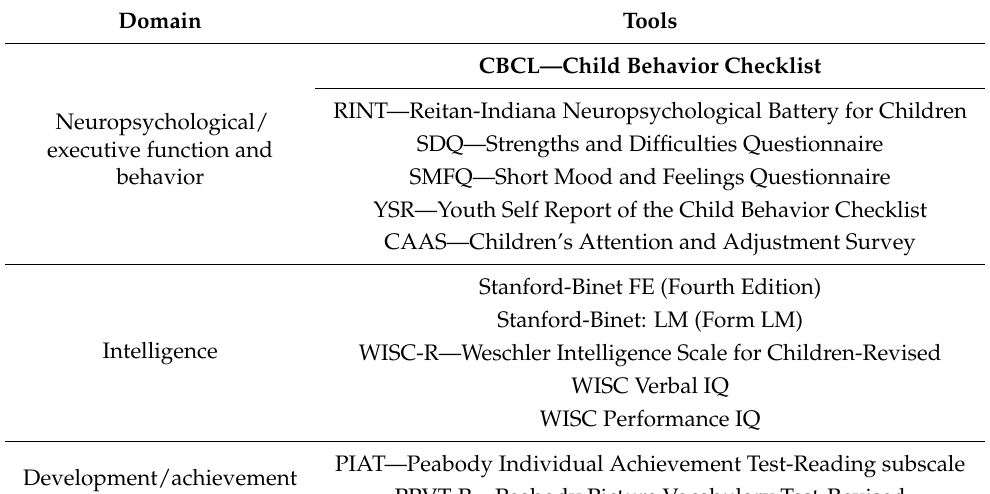
Table 1. Child development assessment tools utilized in included studies, by domain.